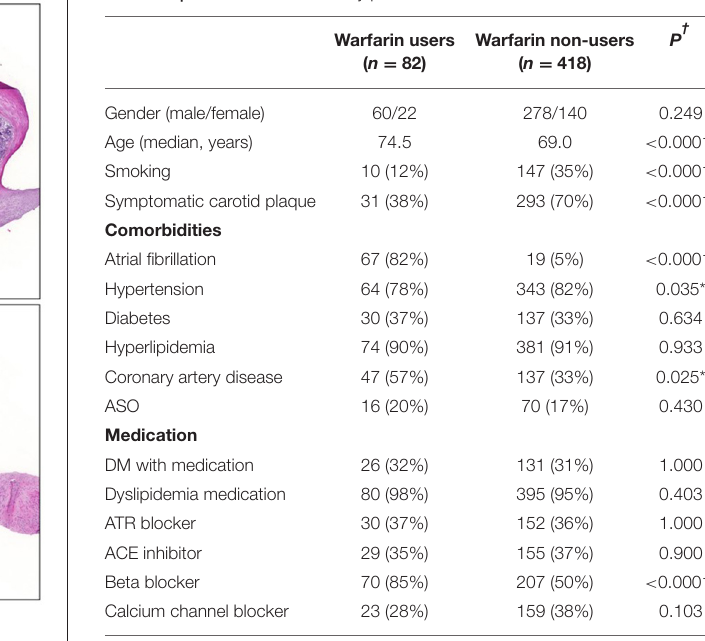
TABLE 1 | Characteristics of study